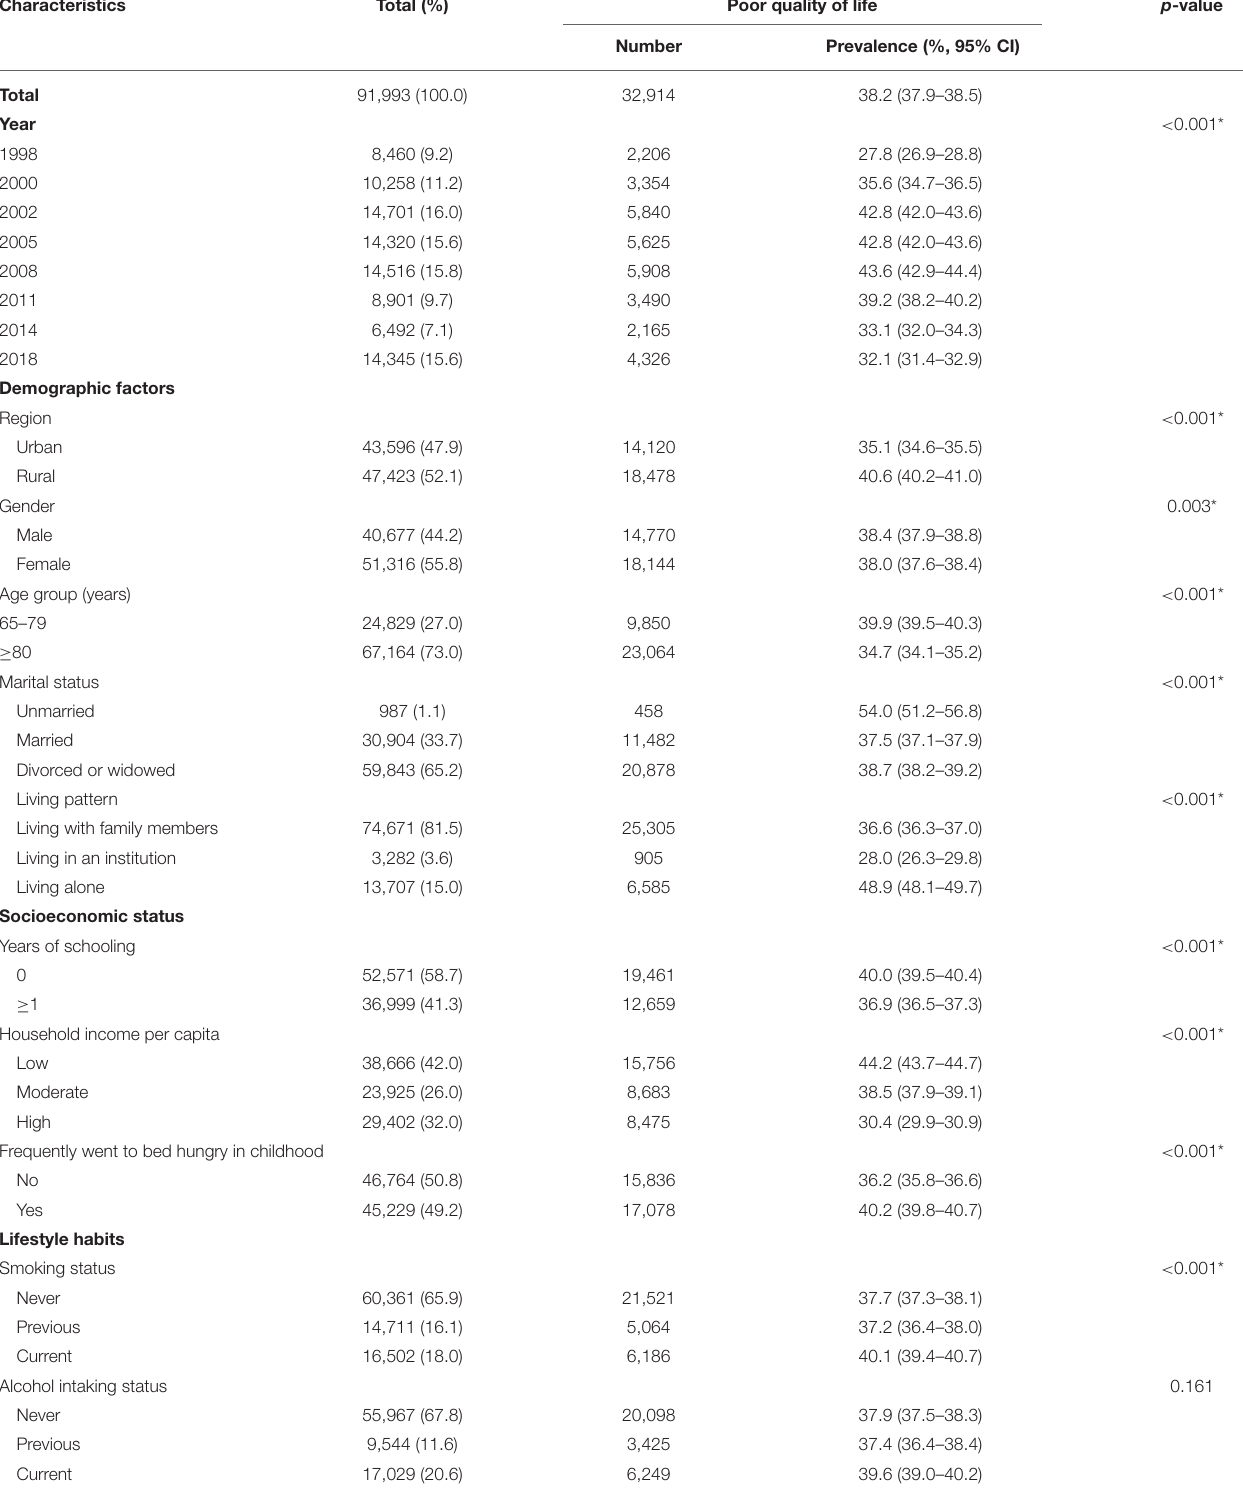
TABLE 1 | Prevalence of poor quality of life by the survey year, demographic factors, socioeconomic status, lifestyle habits, and health status ( N = 91,993).